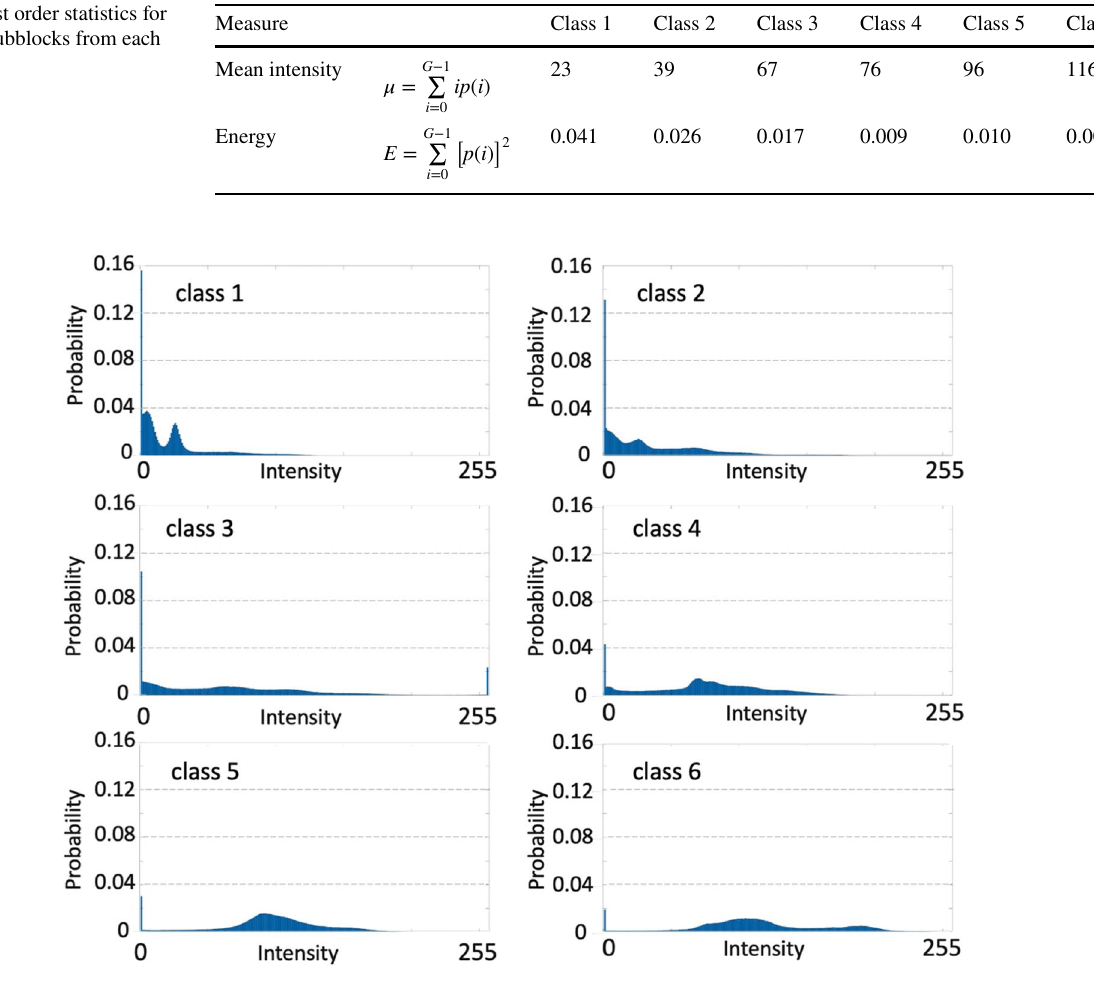
Fig. 14 Probability distribution of voxel intensities for each class of subblocks